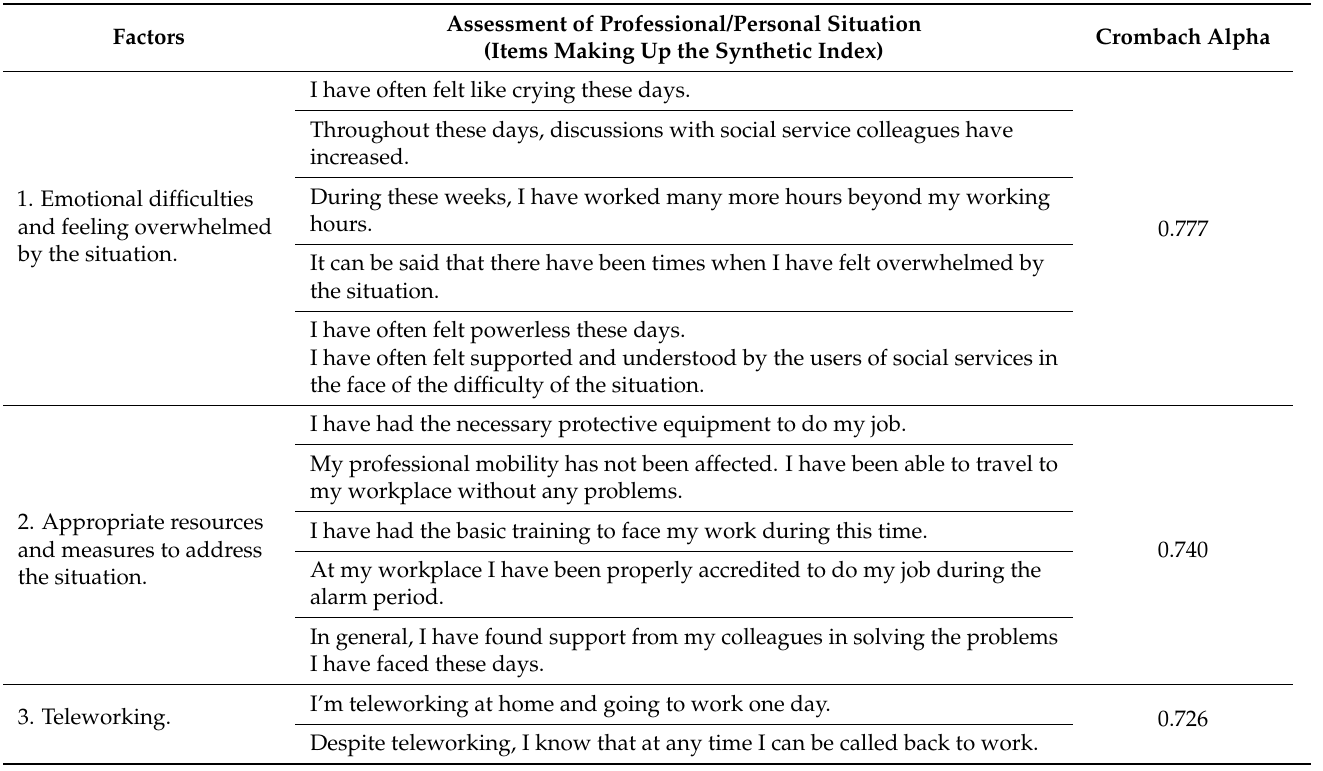
Table 2. Factorial analysis of the professional/personal situation